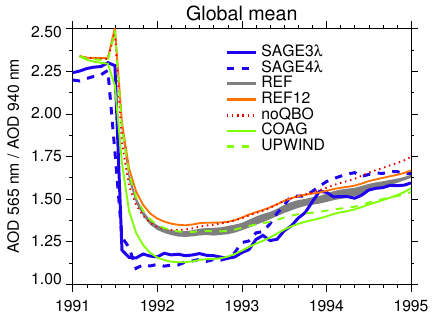
Figure 3. Comparison of remote measurements of aerosol optical depth (AOD) ratios at two wavelengths, a proxy of particle size, with SOCOL-AER simulations. Lines: SAGE-II-derived (SAGE- 3,4 λ ) and modeled global AOD ( > 18km) ratios 565nm / 940nm. Grey shaded area: 2 σ ensemble spread of the REF experiment. All other experiments are shown as ensemble means.